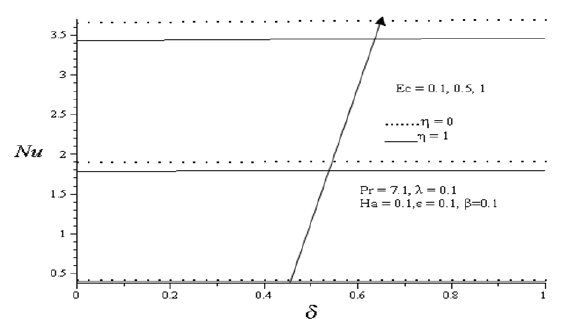
Figure 13. Nusselt number with increasing λ , ε , ( λ ity